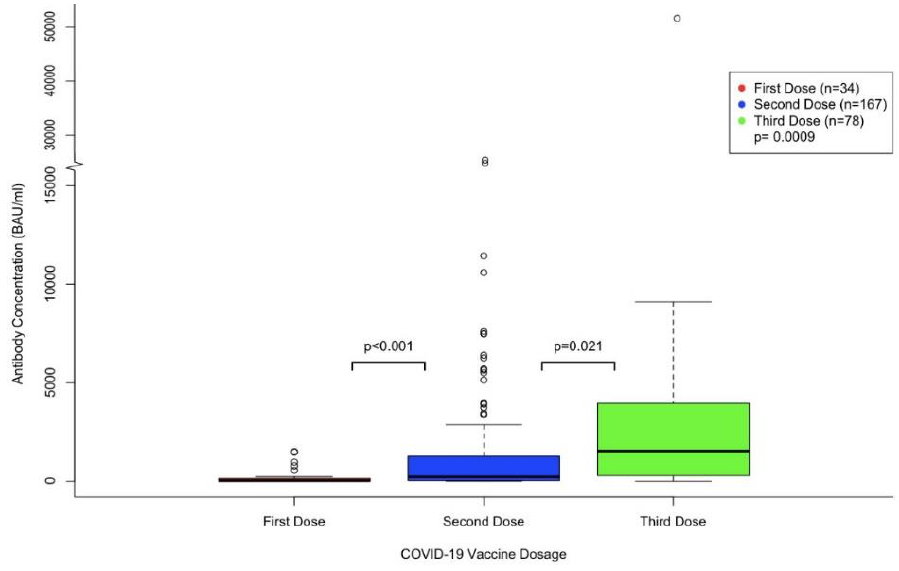
Figure 1. Overall antibody concentration after different doses of the vaccine in cancer patients. Figure 2 shows the change in antibody levels after receiving the first, second, and third dose of each participant’s respective vaccines. Each line is drawn from the antibody levels measured after the first dose, to the second, and then the third dose for the same participant. For all vaccine groups, 90.9% of participants demonstrated a higher second dose antibody concentration than the first dose, and 70.8% had a higher third dose anti- body concentration compared to the second dose (i.e., 29.2% became lower on the third dose). In the BNT162b2 category, antibody concentration between the first and second dose increased by a factor of 9.3 on average, and 3.4 between the second and third dose. It should be noted that decreases in individual antibody concentration were also observed between the second and third dose. 84.6% of participants who received the BNT162b2 vaccine demonstrated an increase in antibodies between the first and second dose, whereas 77.8% of participants demonstrated an increase in antibodies between the second and third dose. In the Mixed Dose category, antibody concentration increased by a factor of 1.03 on average, between the second and third dose. Additionally, 70.4% of participants demon- strated an increase in antibody concentration, while 29.6% demonstrated a decrease. In the mRNA-1273 category, the average antibody concentration between the first and second dose increased by a factor of 3.2, and 100% of participants who had results recorded for their first and second dose demonstrated an increase in antibody concentration. The cohort of AZD1222 vaccine had limited participants and no comparisons between doses could be made. Factors of increase were not provided in the last two categories due to a limited number of participants. An ANOVA was conducted to compare the first (125.5 BAU/mL), second (1169.3 BAU/mL), and third dose antibody concentrations (3918.9 BAU/mL) of the BNT162b2 group, which demonstrated a significant difference in antibody concen- tration between each group ( p < 0.001). A T-test was conducted to compare the second (1839.7 BAU/mL) and third dose (1890.7 BAU/mL) average antibody concentrations from the Mixed Dose category, which demonstrated no significant difference between the an- tibody concentrations ( p = 0.96). Due to a limited number of participants, no statistical analyses were performed for the AZD1222 or mRNA-1273